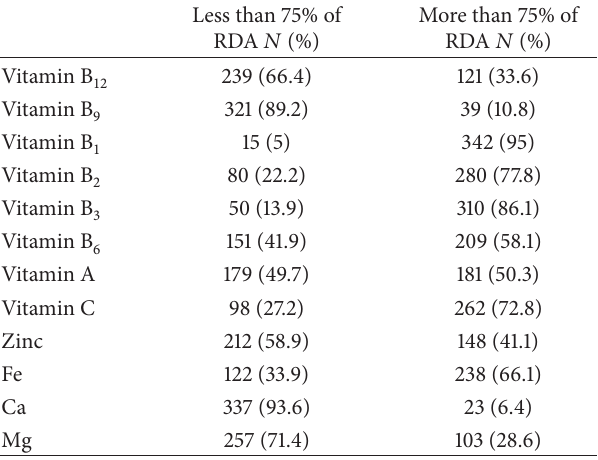
Table 4: Comparison of micronutrient intakes of high school girls in Ilam with